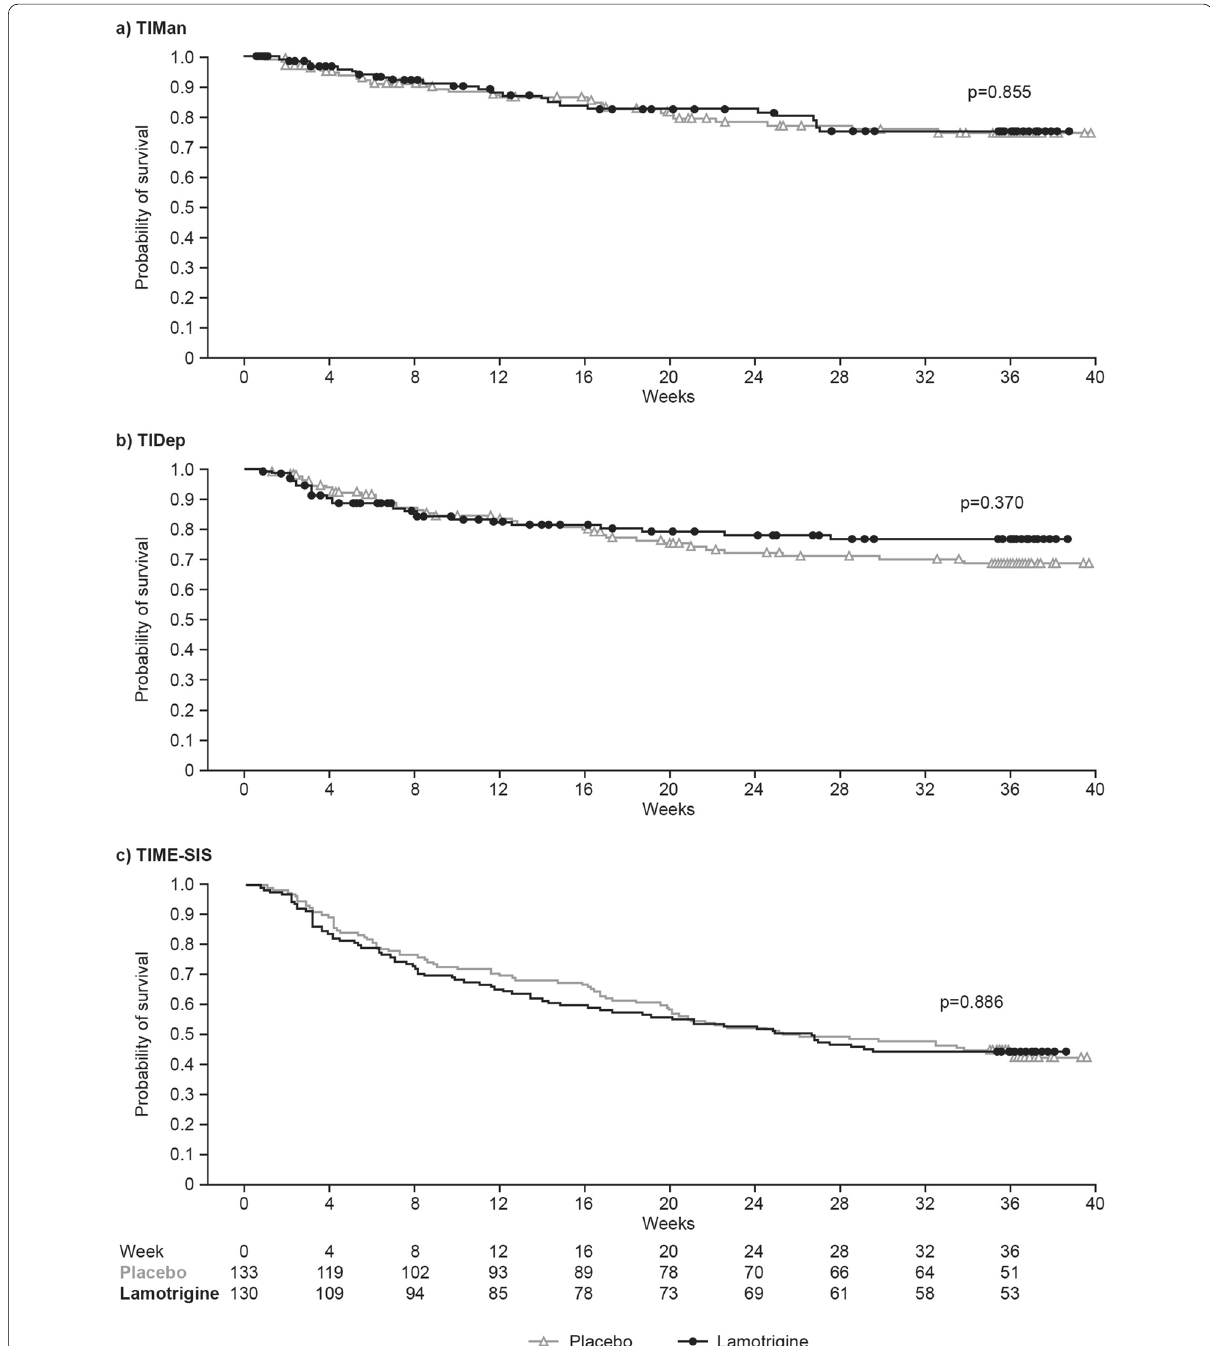
Fig. 3 Kaplan–Meier survival estimates depicting a TIMan, b TIDep and c TIME‑SIS. The p values were calculated using the log‑rank test and is for the PBO versus LTG comparison. Marks represent censored events. Estimates are for the RD FAP. FAP, full analysis population; LTG, lamotrigine; PBO, placebo; RD, randomised double‑blind; TIMan, time to intervention for manic, hypomanic or mixed episode; TIDep, time to intervention for depressive episode; TIME‑SIS, overall survival in